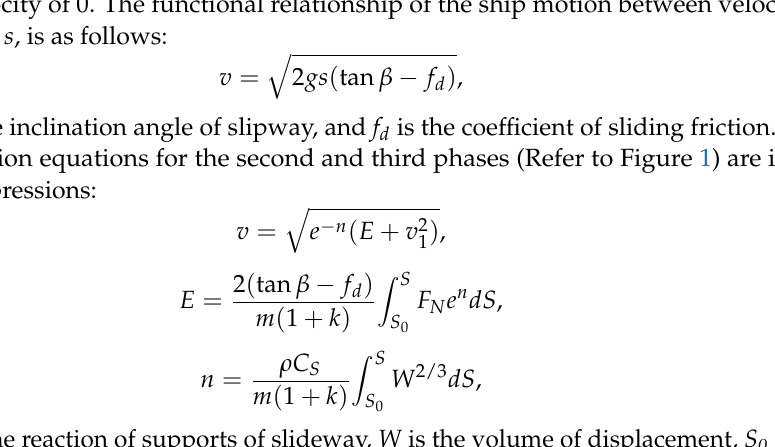
Figure 3. Reaction forces of launching ship on slipway.